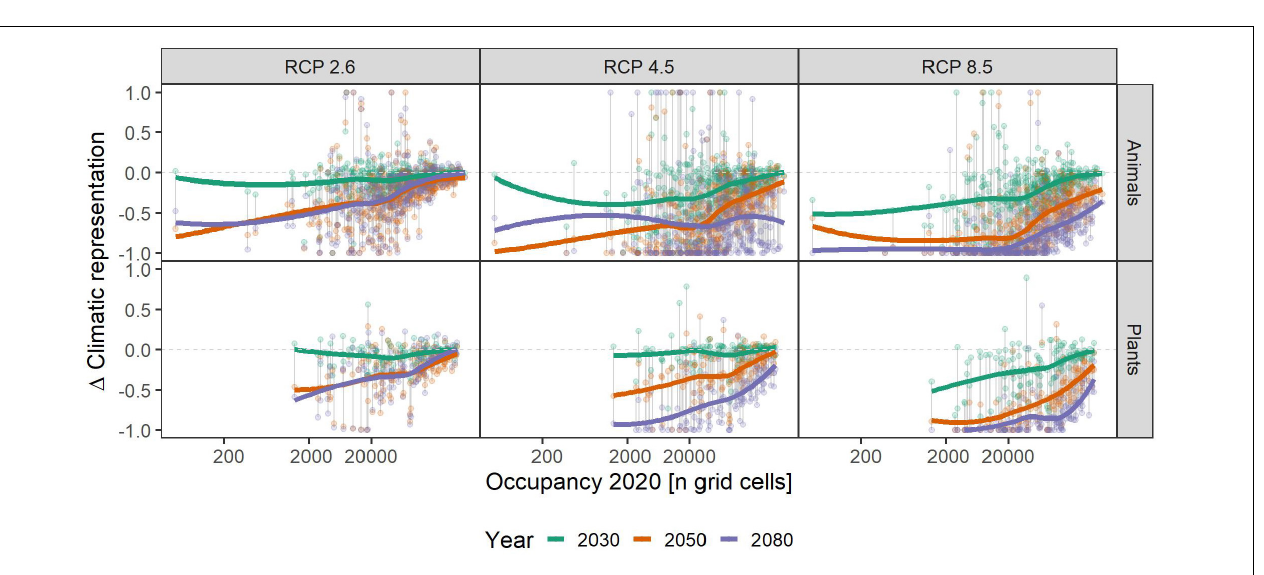
FIGURE 3 | Relationship of species’ assumed area of occupancy and their respective gains and losses of climatic representation in the future under climate change scenarios RCP 2.6, RCP 4.5, and RCP 8.5. Colored, bold lines represent splines within each time-step (colors) and scenario (panels) for overview. Gray vertical lines connect data points belonging to one species. A value of -1 means complete loss of representation, and a value of 1 means a doubling of representation. Please note that some species had a relative change > 1, and that for overview, we set those to 1. See Supplementary Table 1 for